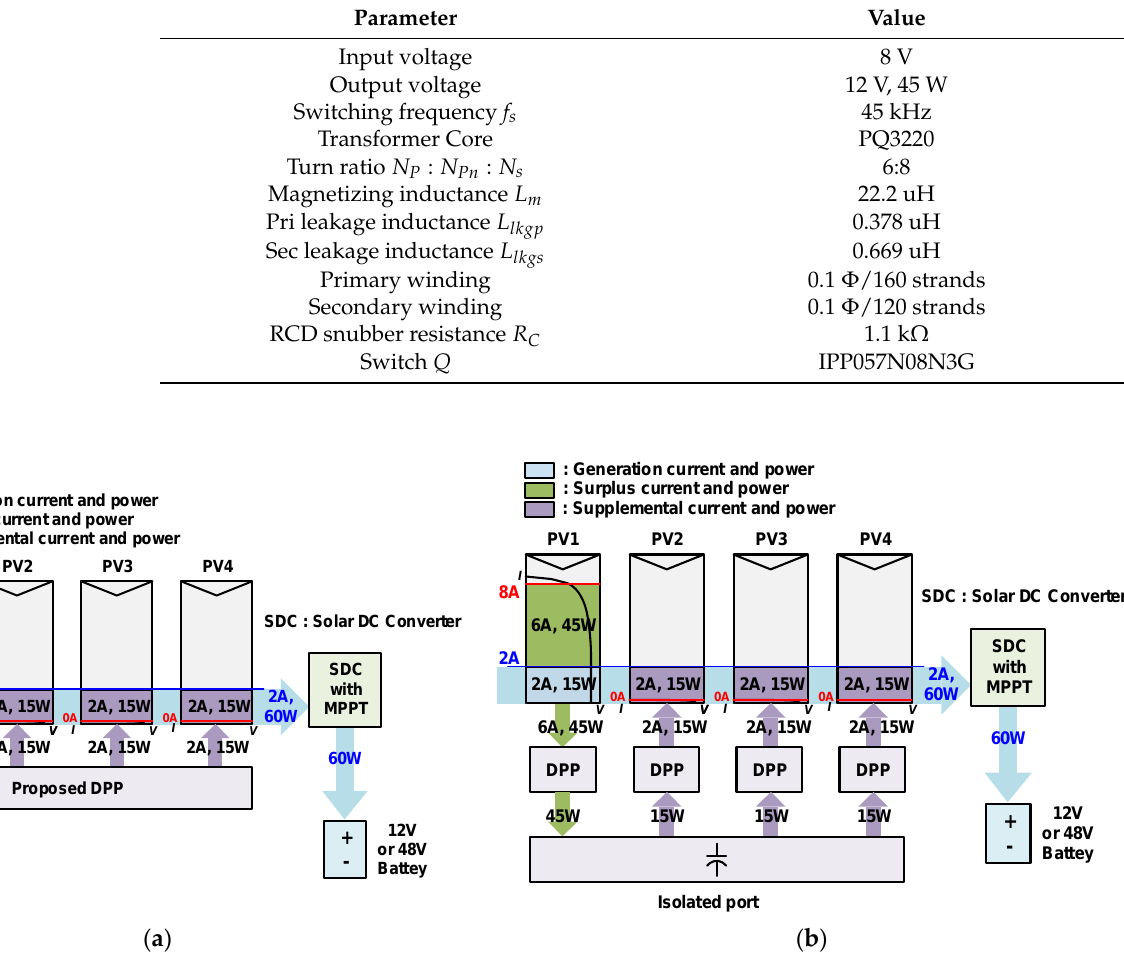
Figure 10. ( a ) Power flowchart of the proposed DPP converter. ( b ) Power flowchart of a conventional flyback DPP converter. Table 3. Proposed DPP converter parameters.